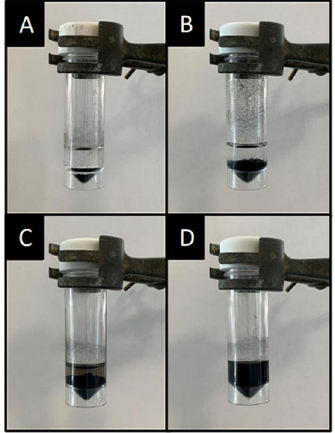
Figure 1. MWCNT suspensions in 10 mL of ( A ) dH 2 0, ( B ) 100% ethanol, ( C ) MES buffer, and ( D ) diamine oxidase enzymatic solution after ultrasonication for 20 min and left undisturbed for 2 h.